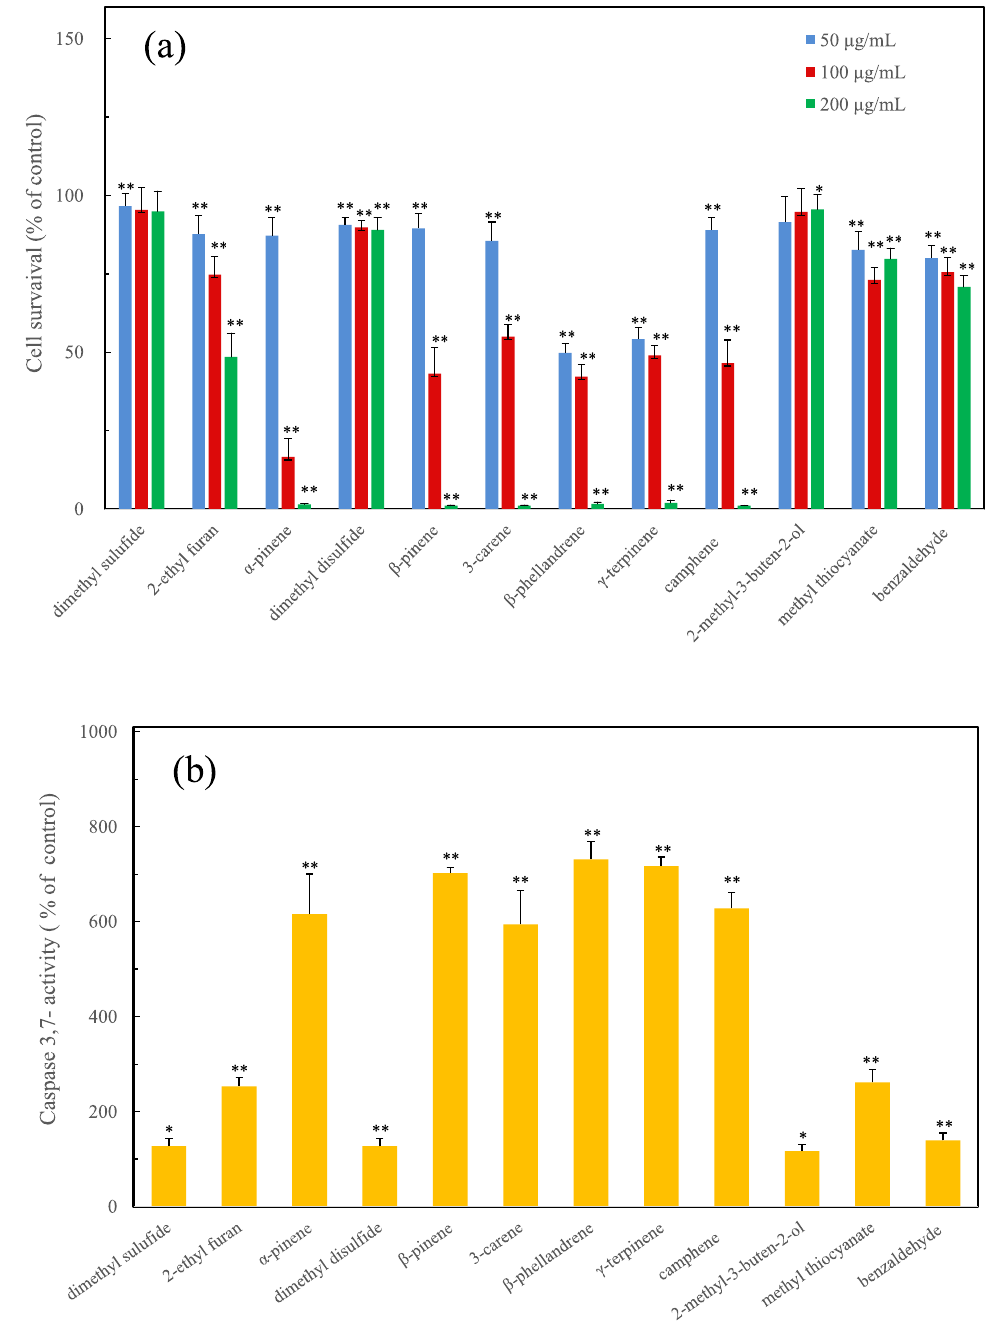
Figure 3. The induction of cytotoxicity with apoptotic cell death due to the initial defensive compounds from the live millipede against RAW 264.7 cells, ( a ) cytotoxicity of the initial defensive compounds. ( b ) caspase activity of the initial defensive compounds. Significant difference was determined by t -test. * p < 0.05 and ** p < 0.01 for the control